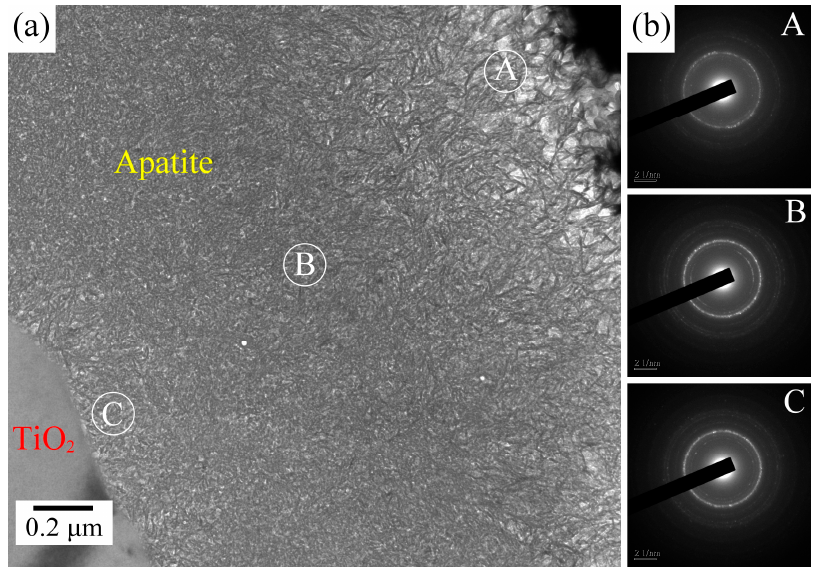
Figure 8. ( a ) Cross-sectional transmission electron microscopy (TEM) image of the Ca–P layer of a Ti sample air-sintered at 900 °C after 21 days of immersion in SBF; ( b ) Three selected-area electron diffraction (SAED) patterns taken from different spots (A, B, and C) indicated in the image of the apatite layer.